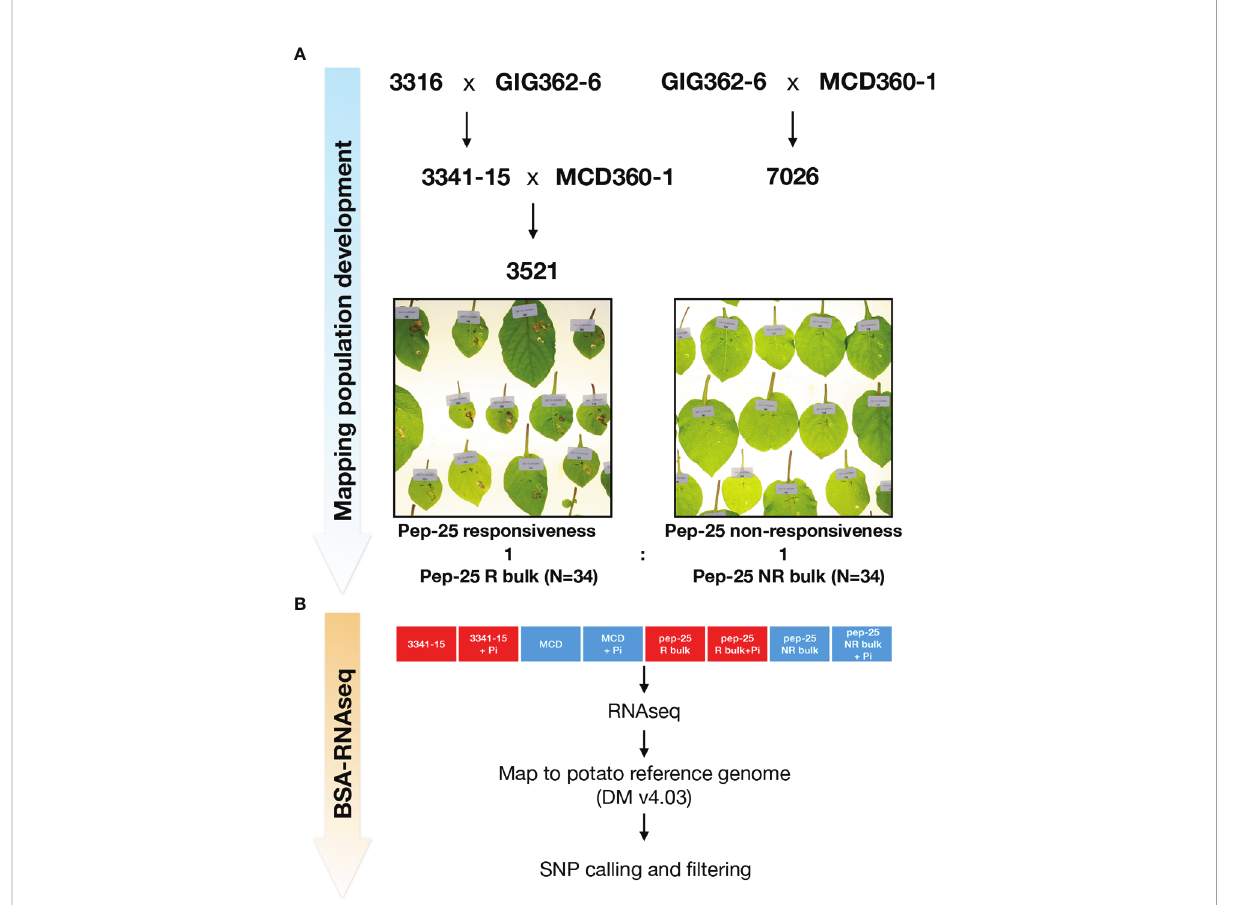
FIGURE 2 Mapping Pep-25 receptor to the top of Chromosome 3 by BSR-Seq (A) Mapping population development for mapping Pep-25 receptor. S. microdontum subsp. gigantophyllum GIG362-6 (R) was crossed with S. verrucosum 3316-17 (NR) and all progenies of the F1 population (3341) respond to Pep-25. Then, the segregating population 3521 was generated by crossing 3341-15 (R) with S. microdontum MCD360-1 (NR). The 34 R and 34 NR progenies were bulked for the BSR-Seq. R, respond to Pep-25; NR, not respond to Pep-25 (B) Two parental lines 3341-15 and MCD360-1, and two bulks (Pep-25 R and NR bulks) were treated with water (mock) or Phytophthora infestans zoospores followed by RNA extraction and RNA-seq. The reads were mapped to the potato reference genome (DMv403), and the SNPs were called, the informative SNPs were fi